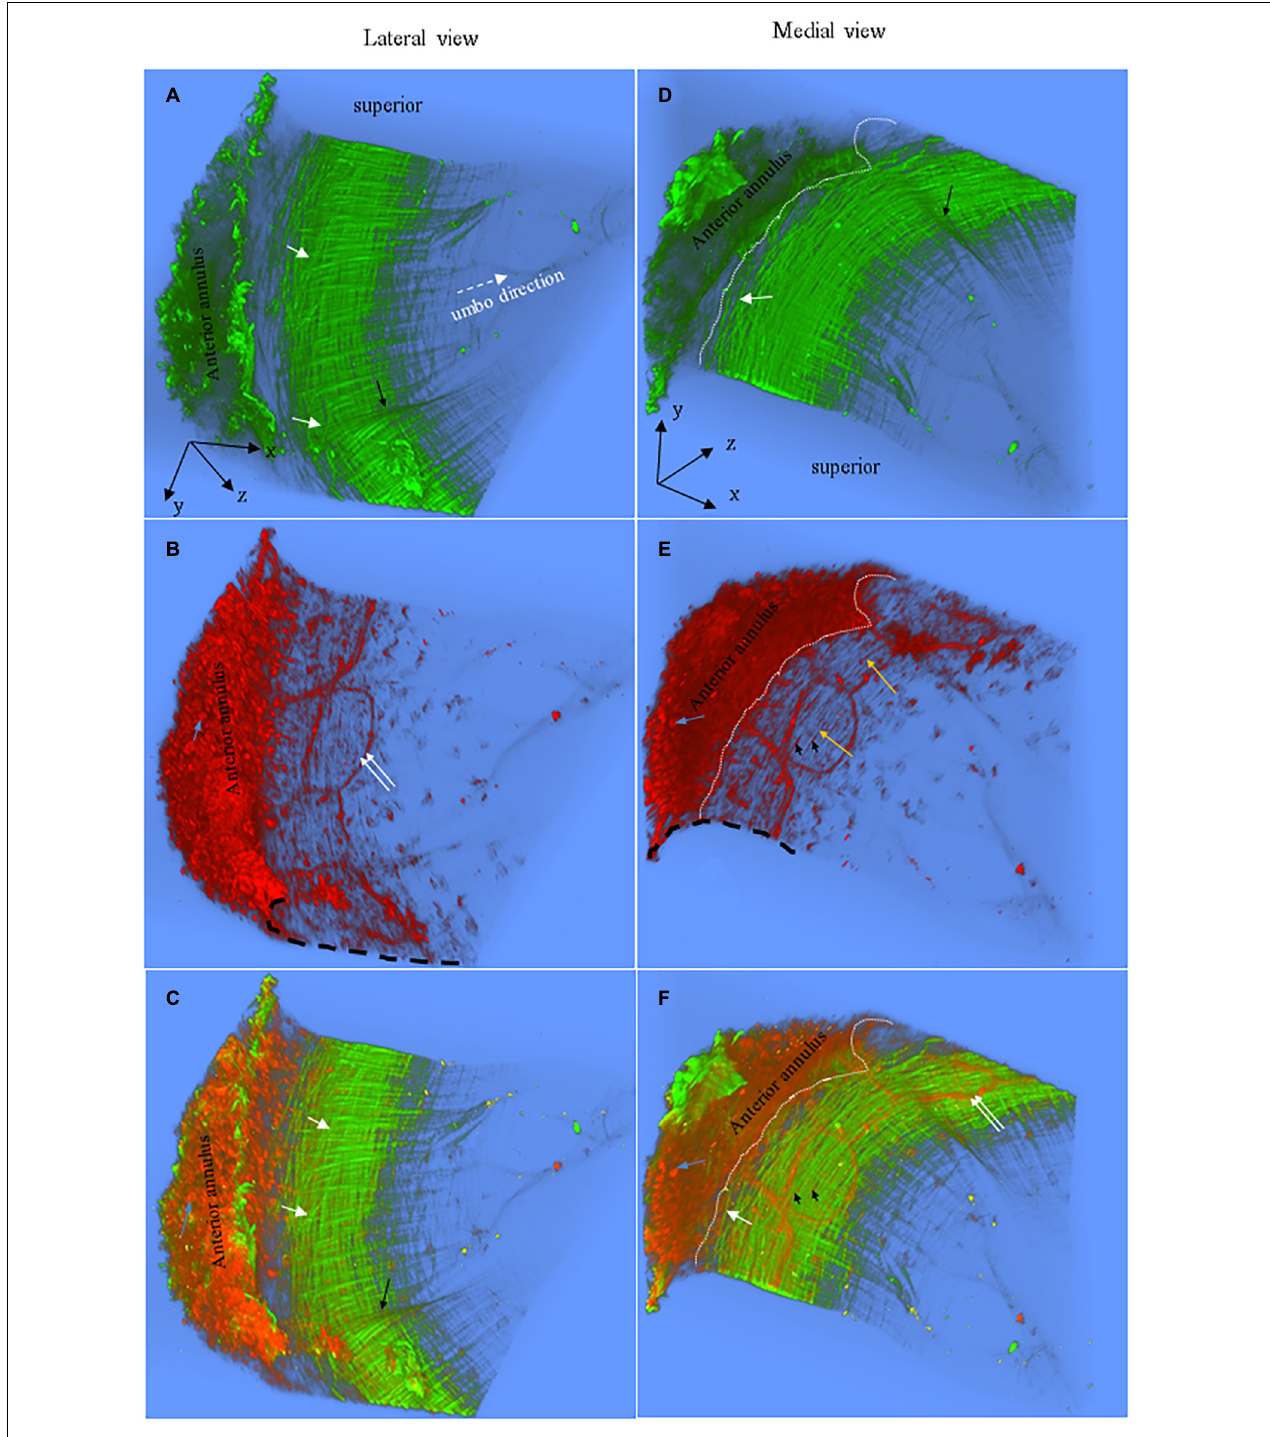
FIGURE 2 | Representative 3D images of the anterior pars tensa-annulus unit reconstructed from SHG (green) and TPF (red) image stacks. (A,D) The lateral and medial view of the 3D collagen network. (B,E) The lateral and medial view of the 3D microstructure of the capillaries (double white arrows), elastic fibers (orange arrows), fibroblasts (black arrowheads) and annulus chondrocytes (blue arrows). (C,F) The merged images dedicate the 3D microstructure arrangement of the collagen network (green) with capillaries (double white arrows), fibroblasts (black arrowheads) and annulus chondrocytes (blue arrows). The 3D collagen network of the pars tensa notably exhibits a waveform contour [black arrows, panels (A,C) ]. The white dash line draws approximately the boundary between the pars tensa and annulus. Field of the view: 509 × 509 µ m 2 .